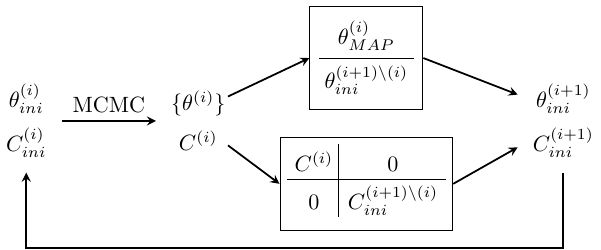
Figure 11. Schematic of the iterative process for parameter calibra- tion. The MCMC sampling of the joint density for the set of param- eters θ (i) starts at θ (i) using an initial proposal covariance C (i) . For ini ini the following iteration, (i + 1 ) , the initial condition is constructed us- ing the MAP estimate for θ (i) , augmented with initial conditions, in (cid:114) (i) this case the nominal values, for the rest of parameters, θ (i + 1 ) . + 1 ) The initial proposal covariance C (i is constructed based on the ini sample covariance matrix for θ (i) , augmented with an initial pro- + 1 ) (cid:114) (i) (cid:114) (i) posal covariance for θ (i + 1 ) , C (i ini